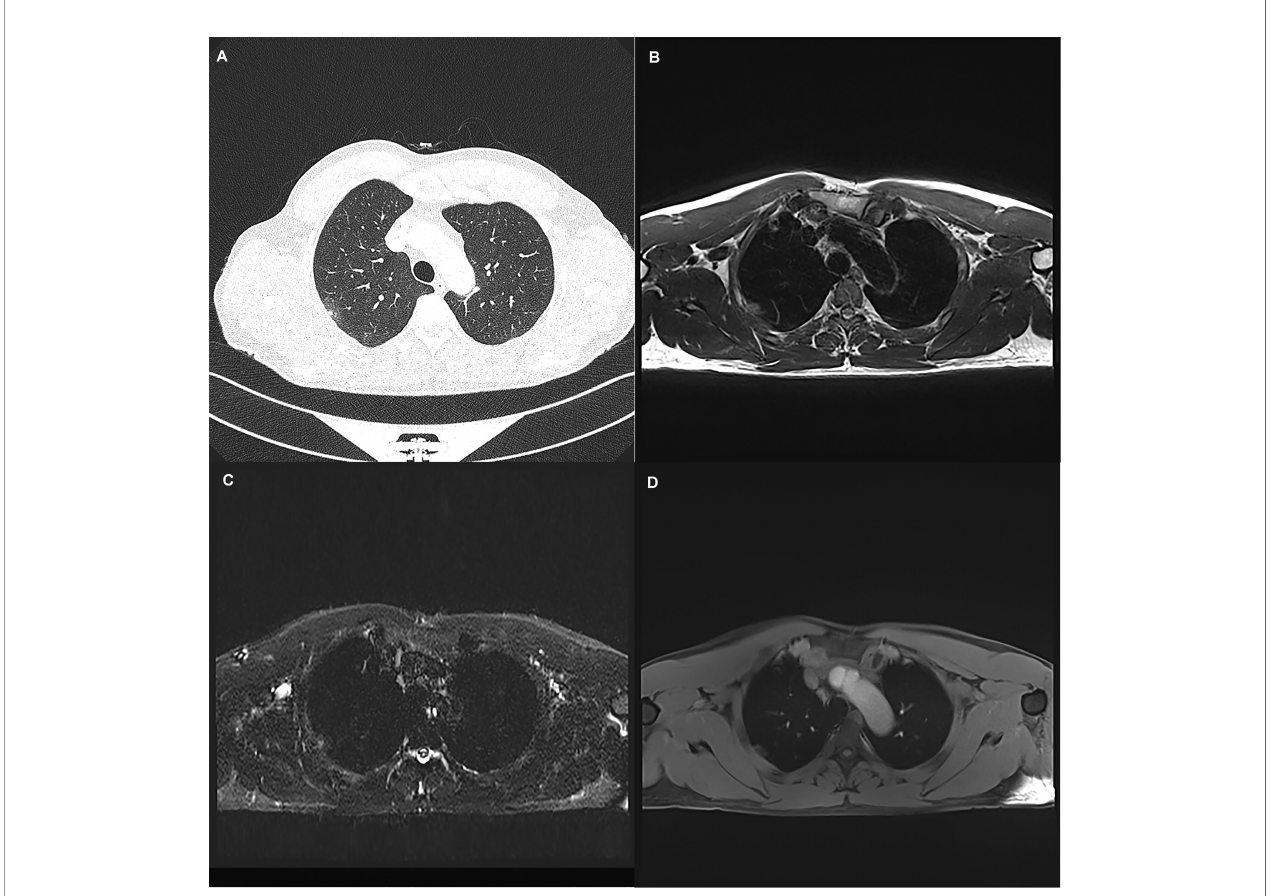
FIGURE 2 | A 45-year-old woman with a 19 mm GGN (arrow) in the right upper lobe. The nodule is clearly seen on the computed tomography image (A) and the magnetic resonance image sequences T2-BLADE (B) , T2-HASTE (C) , and T1-Star-VIBE (D) . The arrows represent the location of the